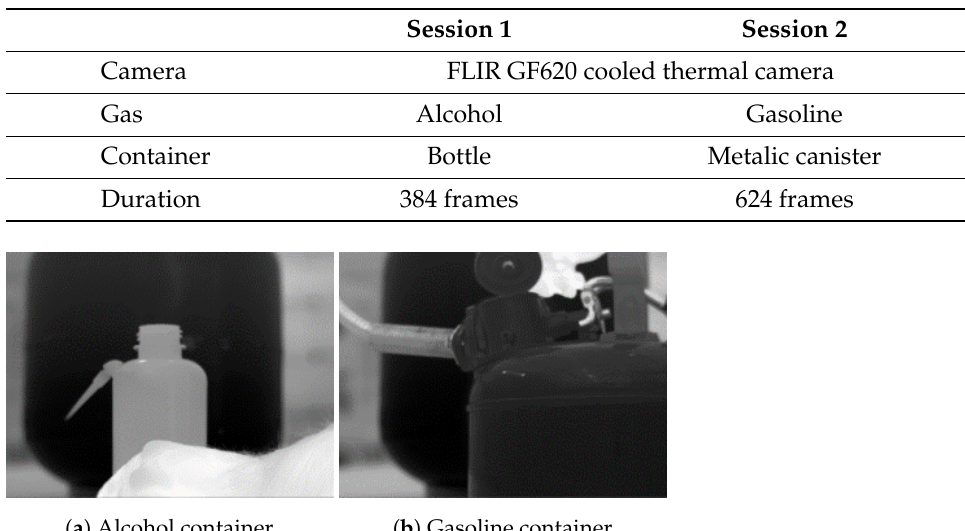
Table 1. Details of the Experiment A.